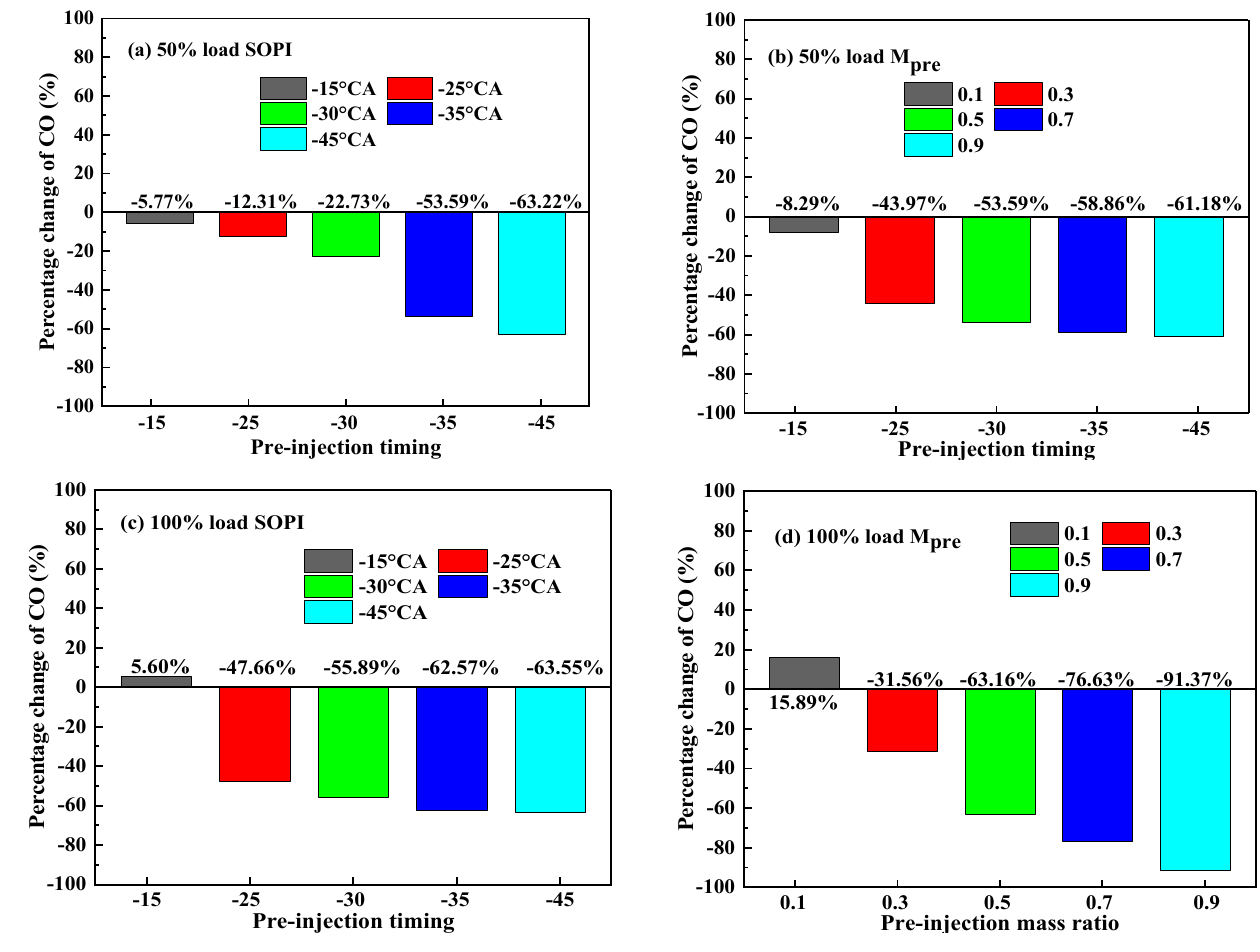
Figure 15. Comparison of the CO percentage change under different load conditions.